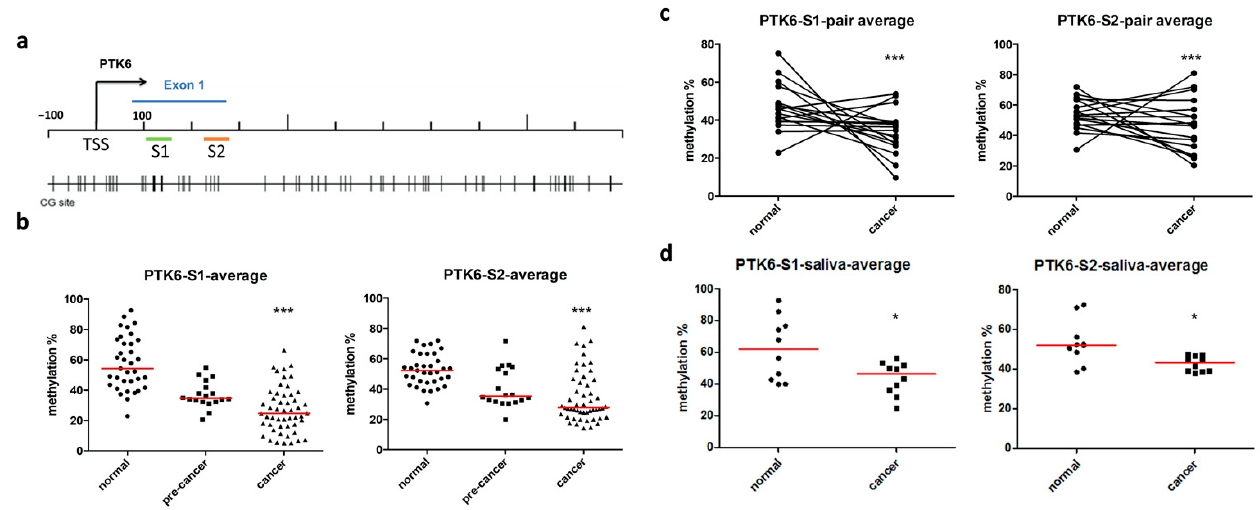
Figure 1. PTK6 was hypomethylated with OSCC development. ( a ) CpG sites on the PTK6 exon 1 and two specific regions were designed for pyrosequencing. ( b ) The methylation levels of PTK6 in 35 normal tissues, 18 precancerous lesions, and 51 OSCC patient samples were measured through bisulfite pyrosequencing. ( c ) The relative DNA methylation of PTK6 in tumor tissues and their corresponding normal tissues from the same patient. ( d ) The methylation levels of PTK6 in 10 normal and 10 OSCC patients’ saliva samples were measured through bisulfite pyrosequencing. * p < 0.05. *** p < 0.005.